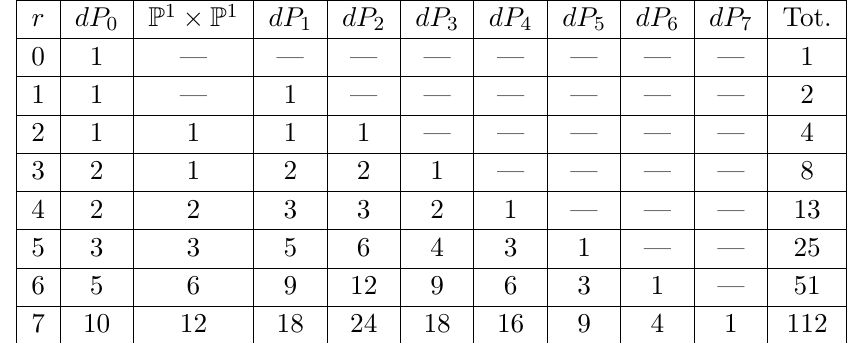
Table 6 . A redundancy removed version of the statistics of di(cid:11)erent blow downs of the dP r surfaces, r = 0 ; (cid:1) (cid:1) (cid:1) ; 7; here, the blow downs are counted up to permutations of the exceptional divisors of the del Pezzo